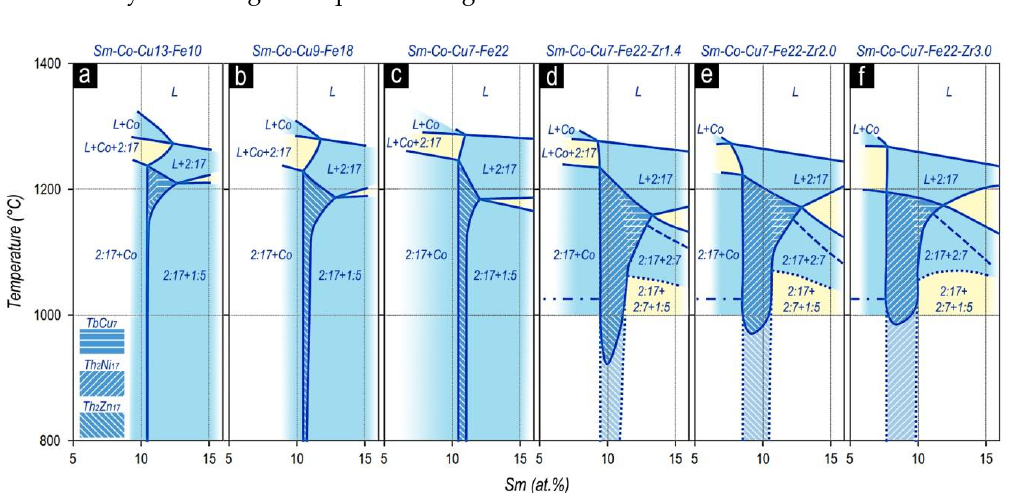
Figure 9. Phase formation in the (Sm,Zr)(Co,Cu,Fe) Z alloys was demonstrated in partial isopleths of quasi-ternary phase diagrams ( a – f ) in the homogeneity range of the 2:17 phase (compilation based on data of Morita et al. [22–24] with some data of Morita et al. [22–24] with some corrections).